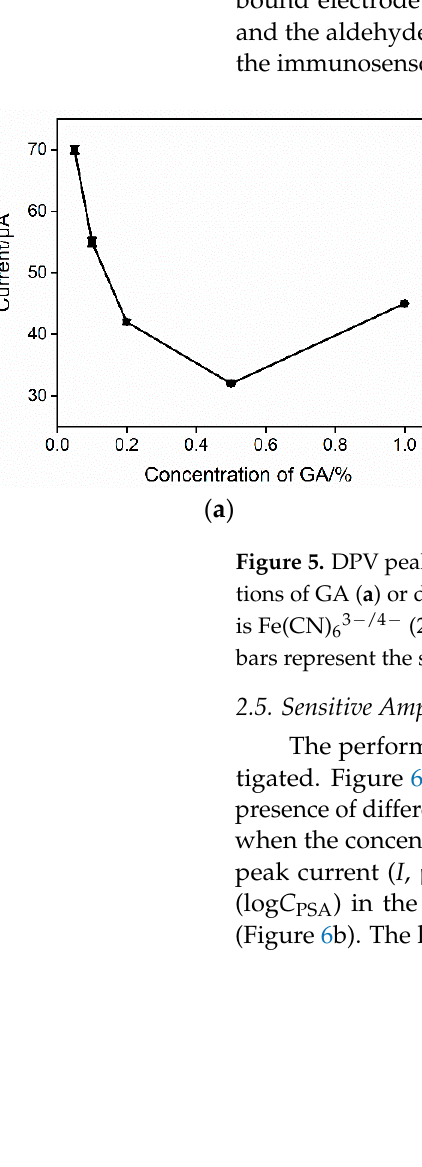
Figure 4. Cyclic voltammetry ( a ) with EIS curves ( b ) from different electrodes. The electrolyte so- lution was Fe(CN) 63 − /4 − (2.5 mM) containing 0.1 M KCl.